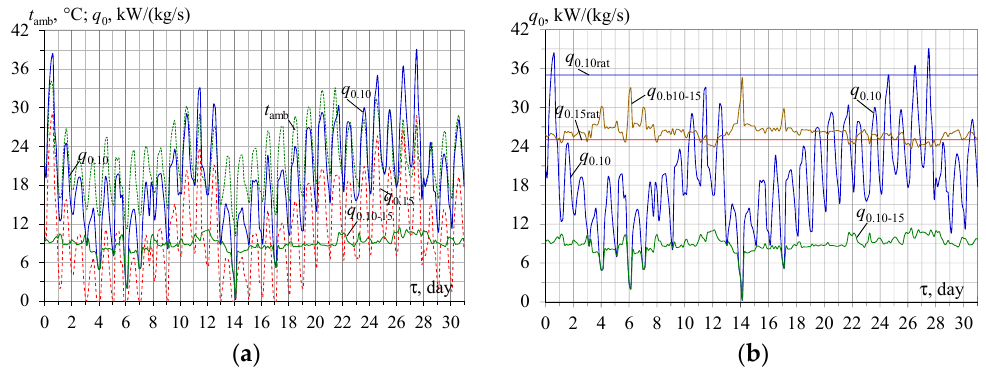
Figure 2. The current values of specific refrigeration capacities q 0.15 and q 0.10 required for outdoor air conditioning to 15 and 10 ◦ C, refrigeration capacities q 0.10–15 for subsequent air conditioning from 15 to 10 ◦ C, ( a ) as well as available booster values q 0.b10–15 as the rest, remaining for outdoor air conditioning to 15 ◦ C ( b ): q 0.10–15 = q 0.10 − q 0.15 ; q 0.b10–15 = q 0.10 − q 0.10–15